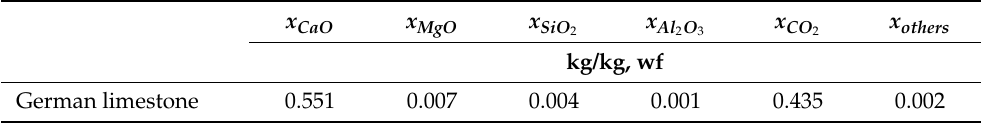
Table 2. Chemical composition ( x i ) of the utilized sorbent (wf: water free).